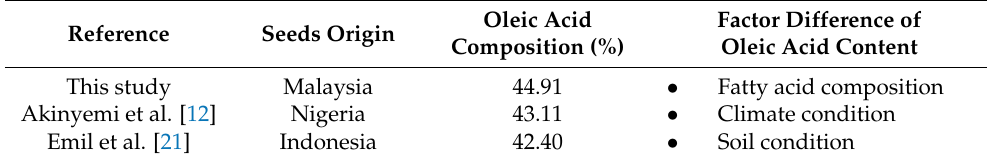
Table 1. Oleic acid composition of Jatropha seed oil extracted from the seeds of Malaysia, Nigeria and